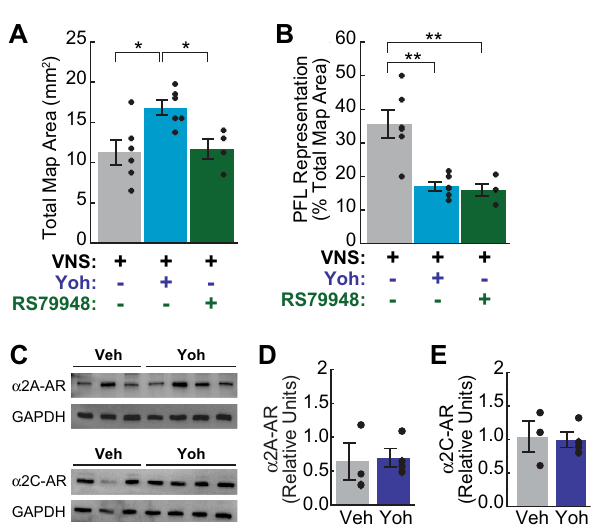
Figure 3. Cortical α2-AR antagonism blocks VNS-driven map reorganization without altering α2-AR protein expression. ( A ) Unlike yohimbine, the selective α2-AR antagonist RS79948 did not increase total motor map area in VNS-treated subjects (n = 4). ( B ) RS79948 infusion blocked VNS-induced expansion of the PFL representation. In ( A ), ( B ), *p < 0.05, **p < 0.01, Tukey post hoc comparison. ( C – E ) Intracortical infusion of yohimbine did not significantly alter the protein expression of α2A adrenoreceptor (α2A-AR, D) or α2C adrenoreceptor (α2C-AR, E) subtypes in M1. In ( C ), protein samples used to quantify expression of α2A-AR (top) and α2C-AR (bottom) were processed in parallel on separate gels. Control signals (GAPDH) were then detected from both membranes in parallel after stripping the primary antibodies of each α2-AR subtype. Images in ( C ) have been cropped to improve the clarity and conciseness of the presentation; full-length blots are presented in Supplementary Fig. 4. In D-E, α2A-AR ( D ) and α2C-AR ( E ) signal intensity is presented relative to same-column GAPDH intensity. Filled circles denote data for individual subjects; error bars denote